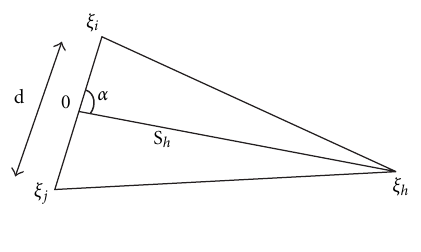
Figure 2.2. The dipole